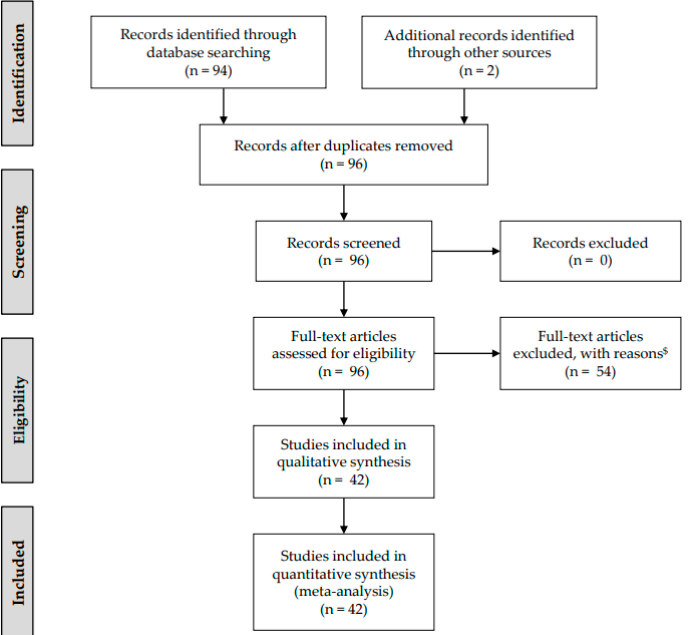
Figure 1. The PRISMA flow chart of evaluation and critical inclusion of the reviewed reports. $: not reporting on fetal surgery.